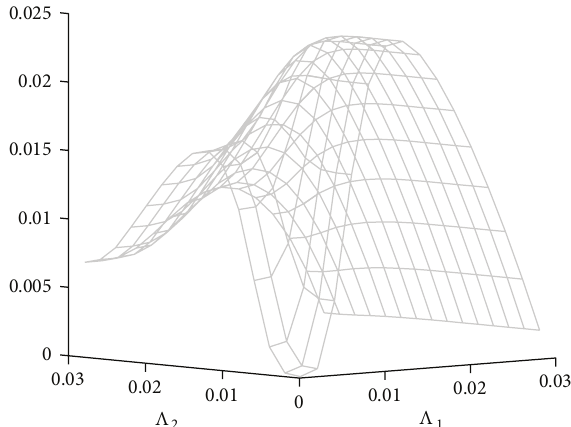
Figure 4: We illustrate here the dependence of 𝑃 Λ (𝜆 0 , 𝑋 0 ) as a function of Λ ; this allows for finding the optimal ( Λ ∗ 1 = 122 bps, = 64 bps) that maximizes the option Λ ∗ 2